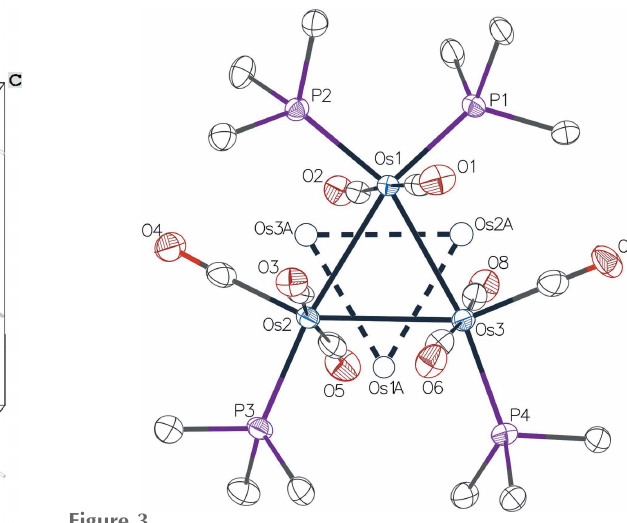
Figure 3 View of the major and minor components of the disordered triangular Os 3